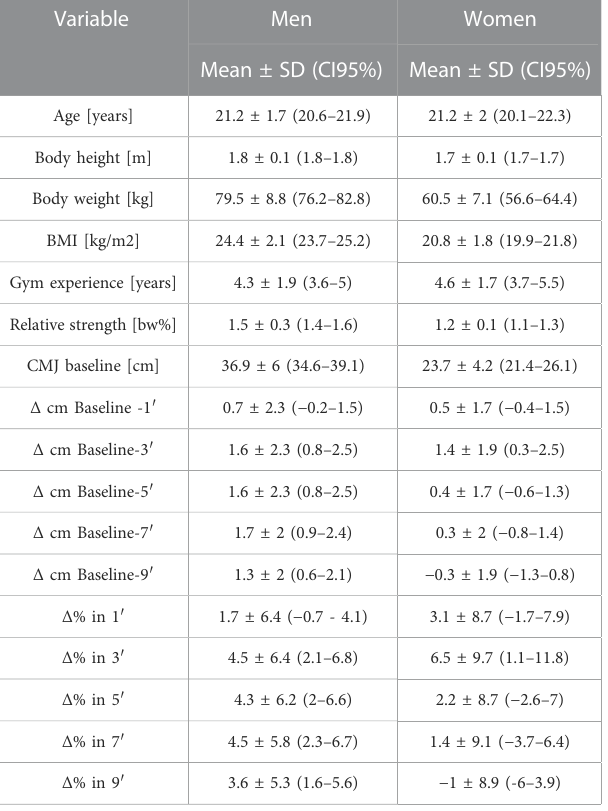
(seven participants) and in the seventh minute (eight participants), indicating that the positive effects occurred faster among females.